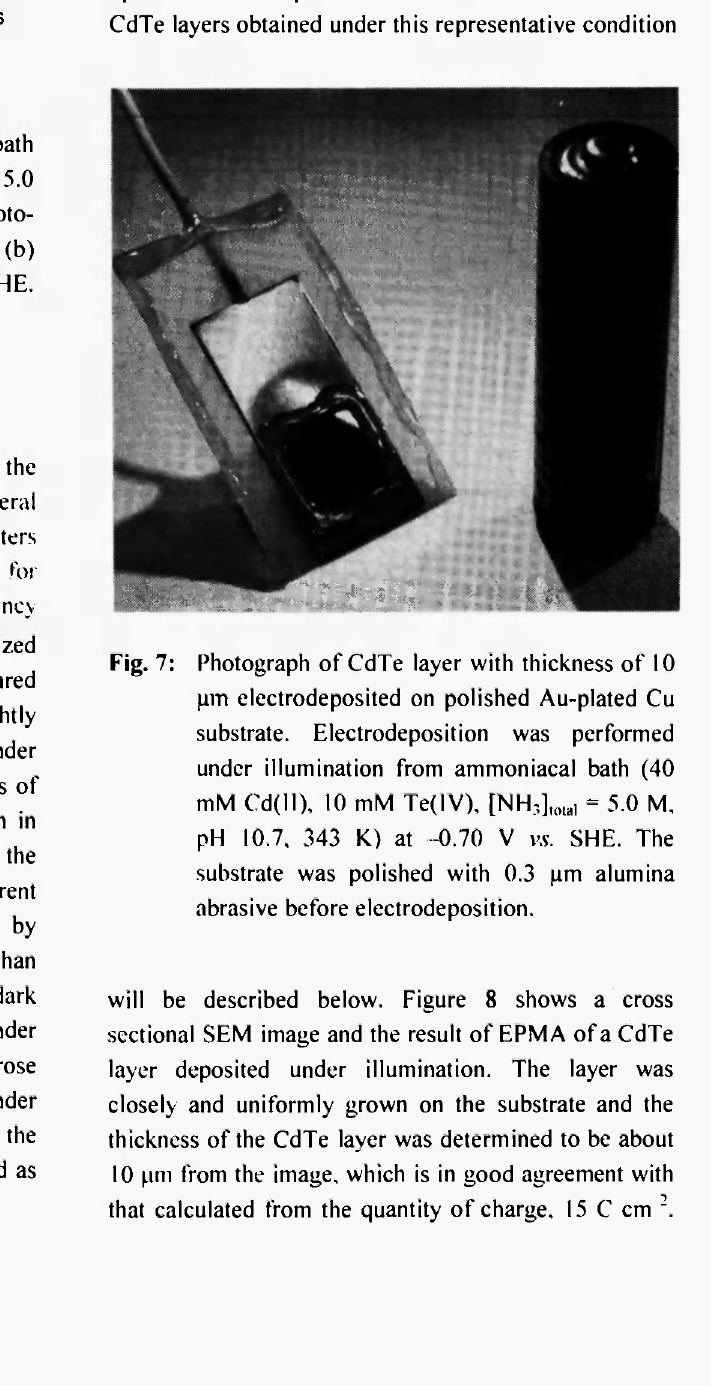
Fig. 6: Cyclic voltammograms for ammoniacal bath (60 mM Cd(li), I0 mM Te(lV), [NH 3 ] I0W | - 5.0 M, pH 10.7, 343 K) under pulsed photo- irradiation: (a) cathodic part (Ist scan); (b) anodic part after switching at -0.75 V vs. SHE. Sweep rate was 10 mV s .